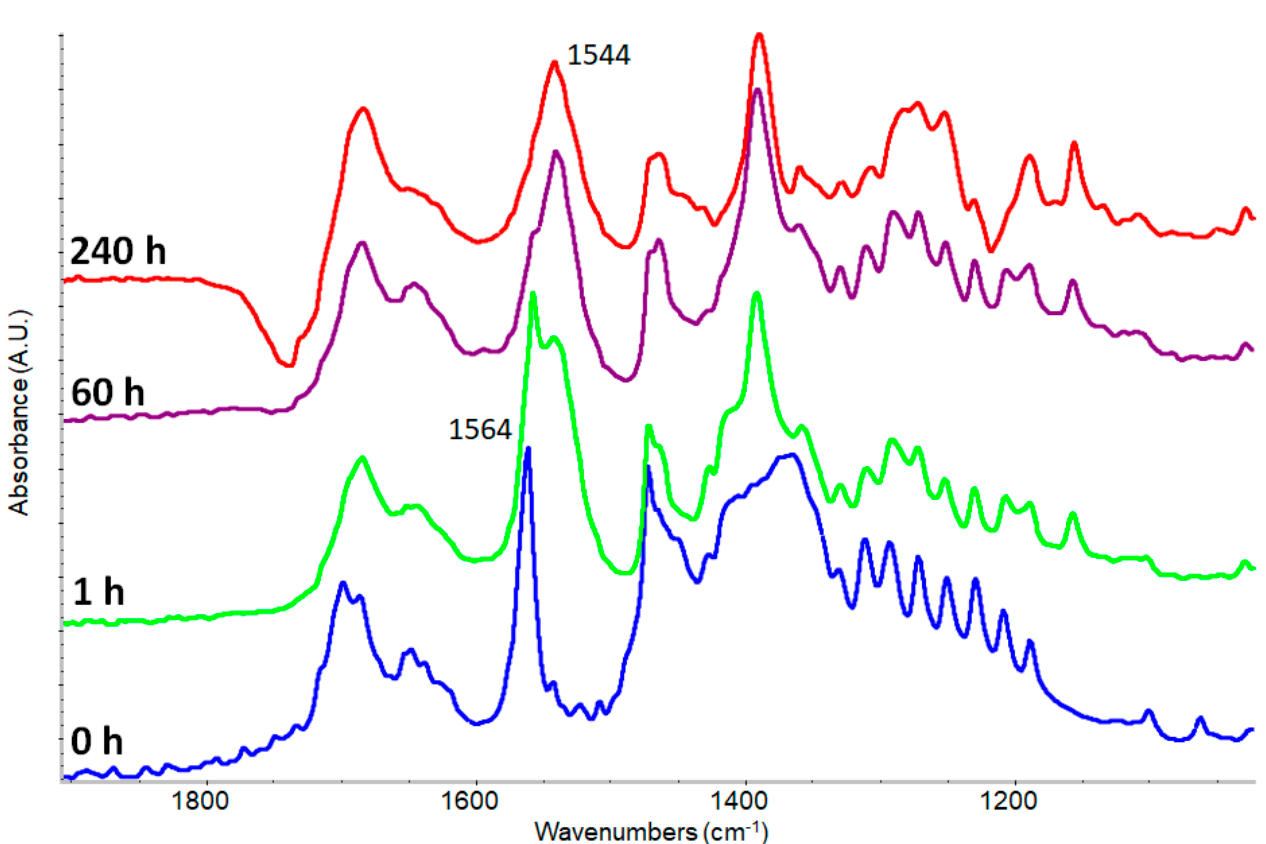
Figure 7. Kinetics of potassium palmitate mixed with fresh added abietic acid in the spectral range from 1100 to 1800 cm − 1 . Before the mixing (blue line), after 1 h (green line), after 60 h (violet line) and after 240 h (red line).